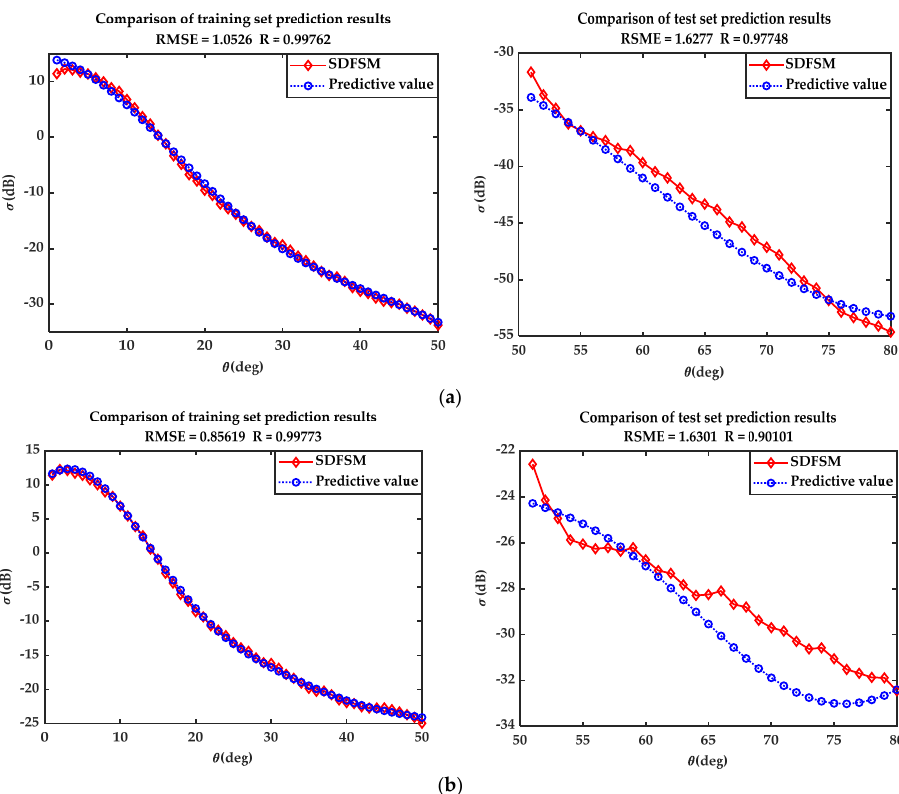
Figure 8. Comparison of the extrapolated prediction results of the GA-SVR-based prediction model and the simulation results of SDFSM. ( a ) Bestc = 36.7740, bestg = 0.3687, HH polarization. ( b ) Bestc = 48.5860, bestg = 0.9666, VV polarization.